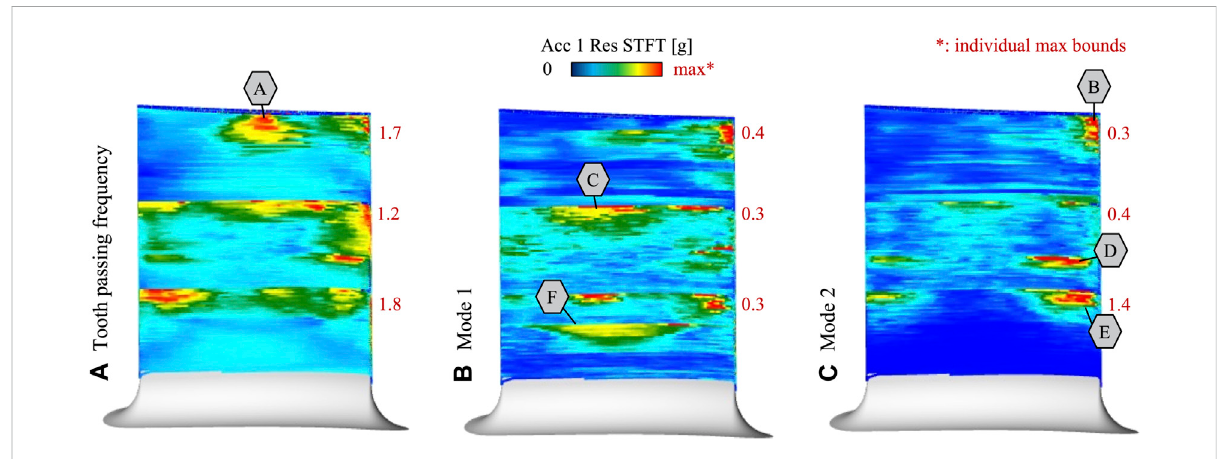
FIGURE 13 Process data for TPF and mode shapes 1 and 2 (following simulated eigenfrequencies). (A) Tooth passing frequency, (B) Mode 1, (C) Mode